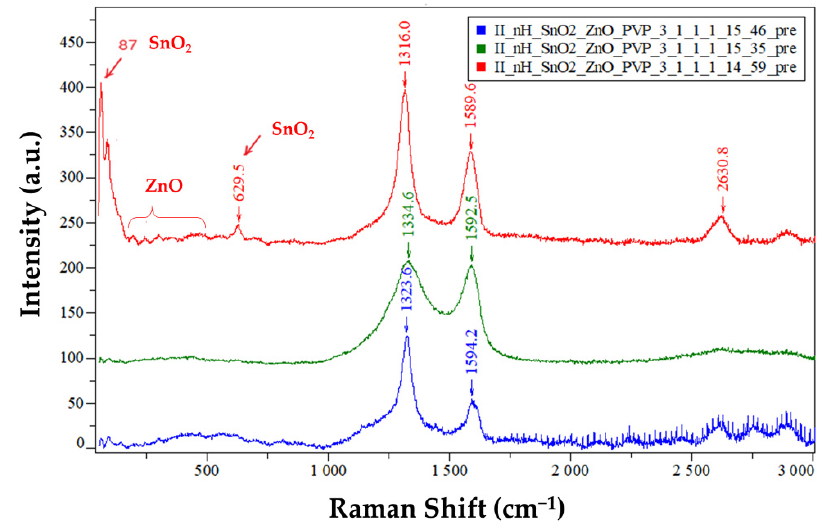
Figure 6. Raman spectra of solid-state films of CNHox /SnO 2 /ZnO /PVP = 3/1/1/1 (mass ratio) deposited on a silicon substrate in three different film positions, plotted in red, green, and blue color